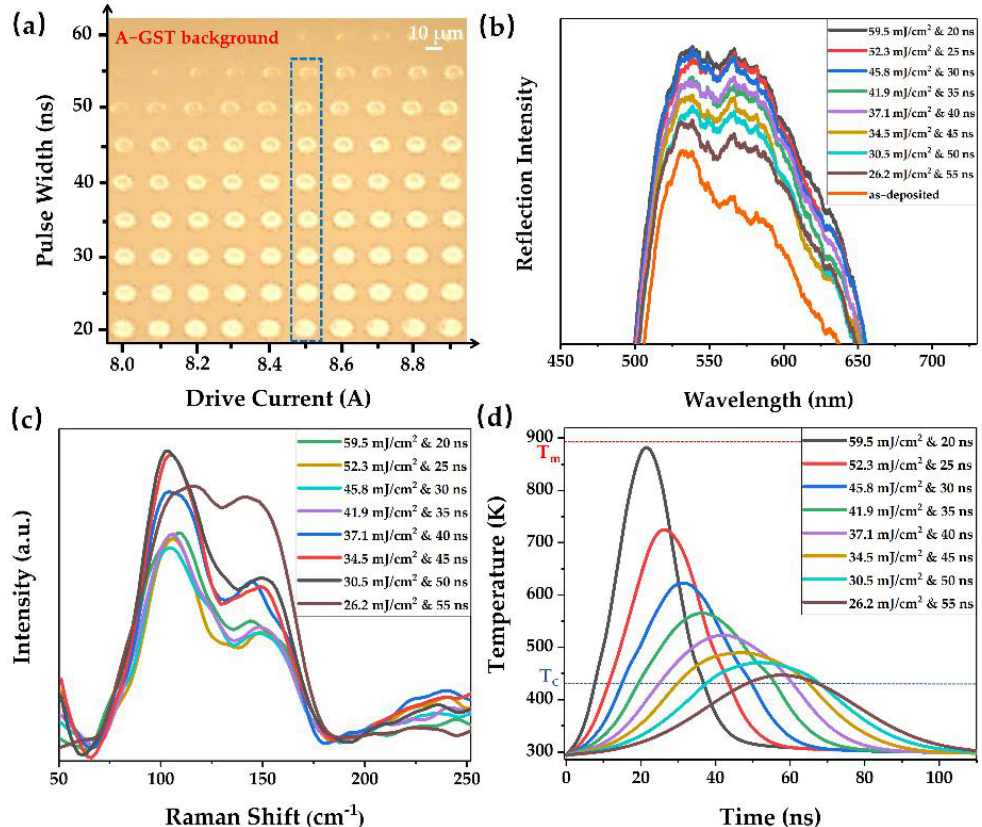
Figure 4. The characterization of multi-level intermediate states on an a-GST film induced by 10 laser pulses with varying drive current and pulse widths by ( a ) optical microscope image, ( b ) reflection spectra, ( c ) Raman spectra and ( d ) thermal